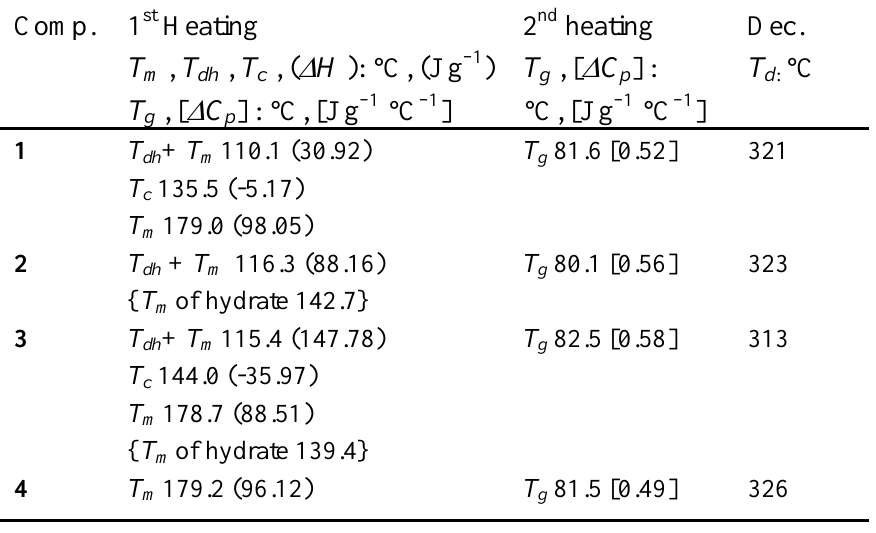
Table 4. The phase transition temperatures, their enthalpy changes and decomposition temperatures of solids 1 – 4